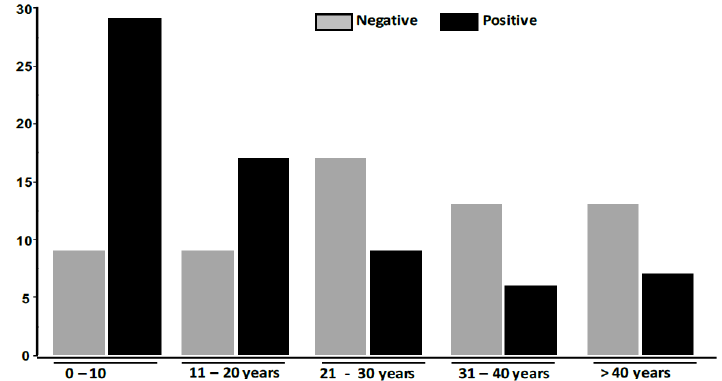
Figure 1. Distribution of Tinea capitis according to age groups.